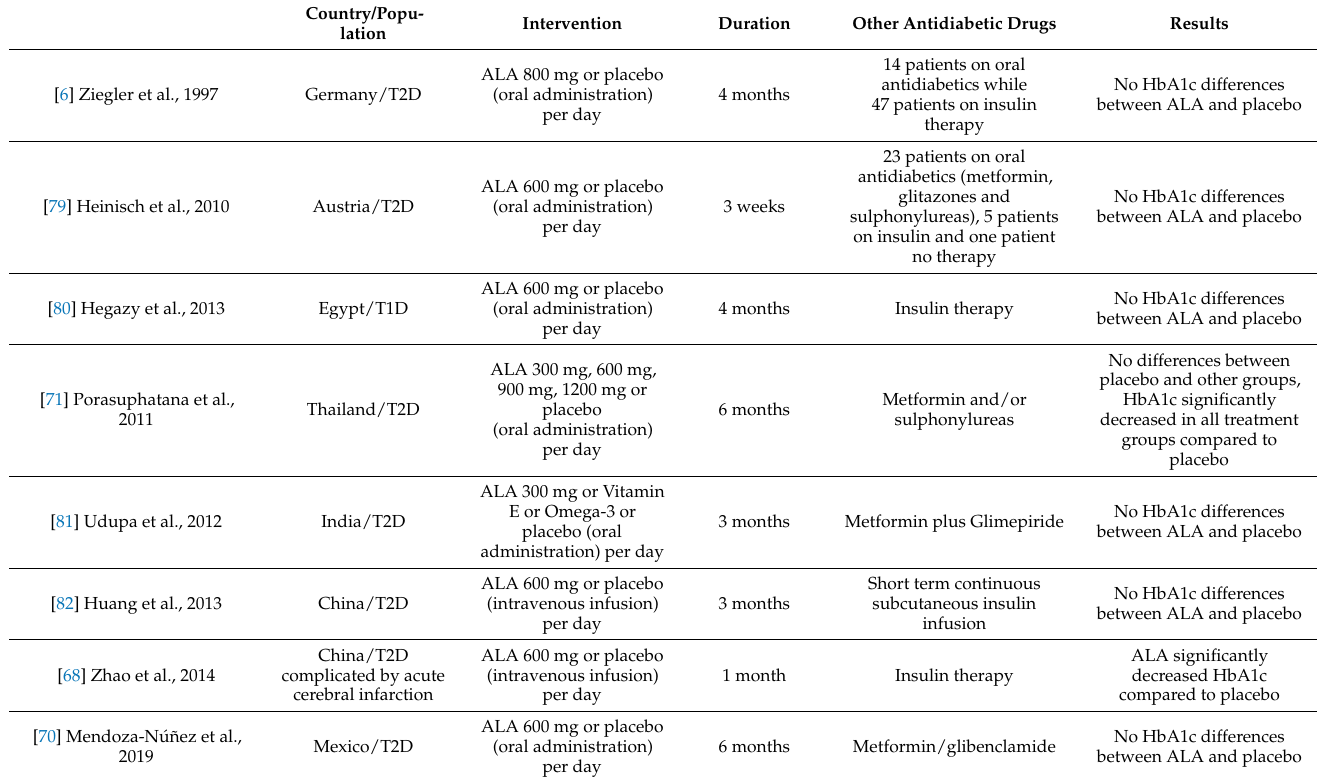
Table 1. Studies on ALA’s effects on HbA1c